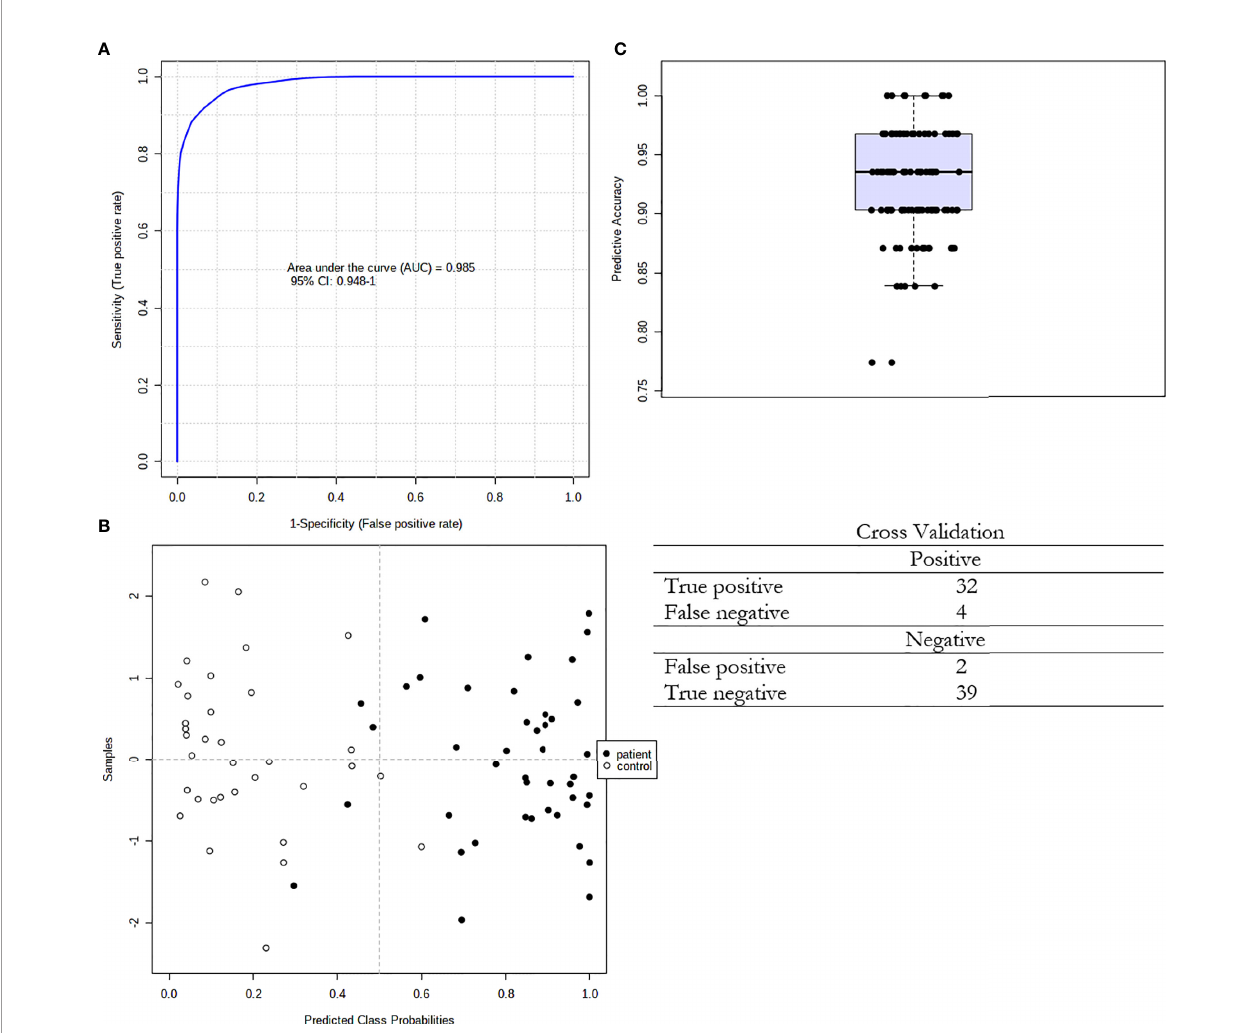
FIGURE 5 | Multivariate ROC curve exploration. (A) Plot of the ROC curve for the created biomarker model based upon its average performance across all Monte Carlo cross-validation runs. The 95 percent con fi dence interval can be computed; (B) Plot of the predicted class probabilities for all samples using the created biomarker model. Due to balanced subsampling, the classi fi cation boundary is at the centre (x=0.5, dotted line); (C) Box plot of the predictive accuracy of the created biomarker model. The average accuracy based on 100 cross validations is